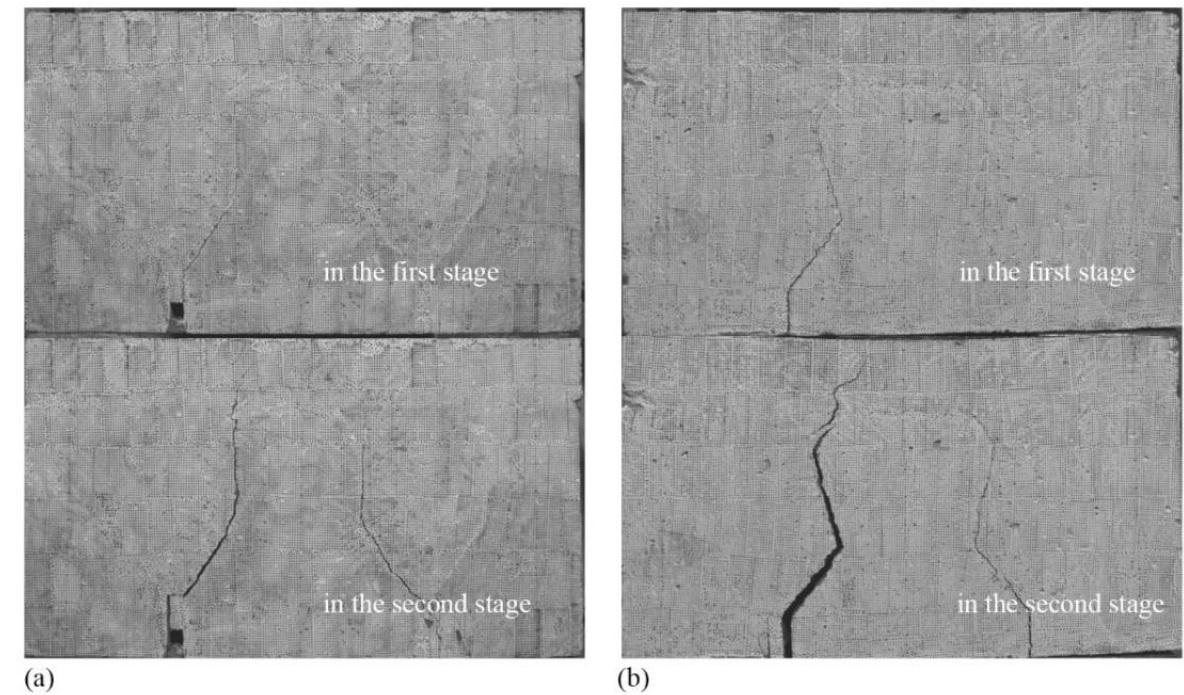
Figure 9. Failure modes of specimens: ( a ) Type III specimen; ( b ) Type IV specimen.